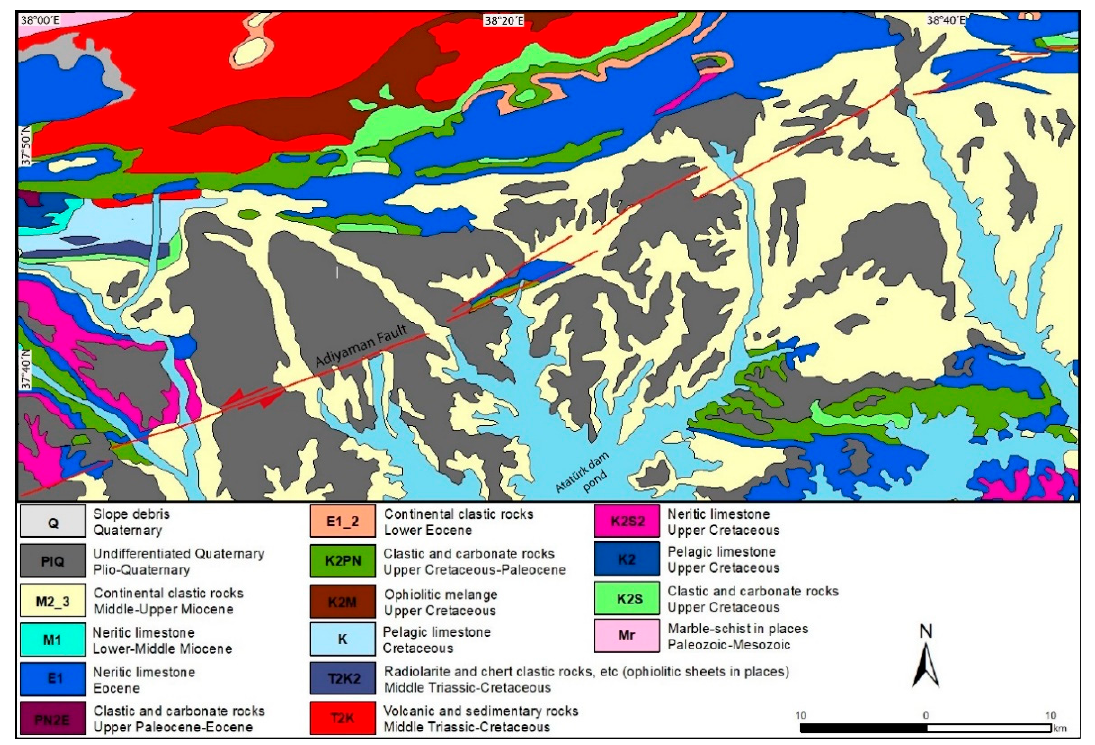
Figure 2. Lithologic map of the Ad ı yaman fault zone (from [22]).